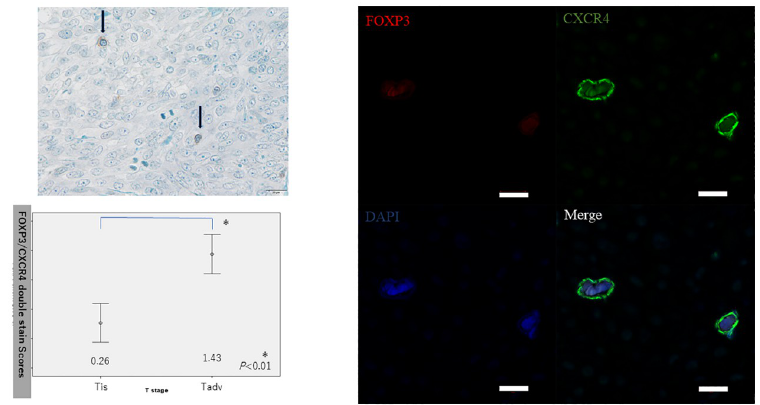
Fig 3. Double CXCR4/FOXP3 immunostaining to evaluate CXCR4-positive Treg infiltration in whole tissue samples. (Left upper) Black arrows: double staining, nuclear (blue: FOXP3), and cytoplasm and cell membrane (brown: CXCR4) (scale bar: 20 μ m). (Left lower) A higher proportion of Tadv cancers expressed CXCR (score: 1.43) compared with Tis cancers (score: 0.26) ( P < 0.01). (Right) Double CXCR4/FOXP3 staining in Tregs was examined by immunofluorescence using specific antibodies. Scale bar = 20 μ m.